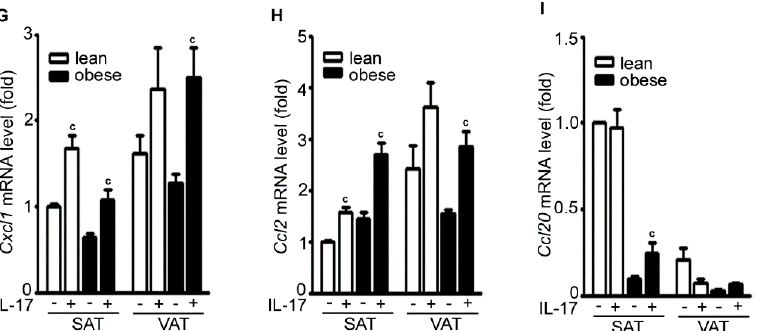
Figure 2. IL-17A differentially induces inflammatory gene expression in the adipose tissues of lean and obese mice. ( A – I ) Adipose tissues were cultured in serum-free Dulbecco’s Modified Eagle Medium (DMEM) and treated without ( − ) or with (+) 20 ng/mL IL-17A for 2 h; mRNA expression of each gene was analyzed with qRT-PCR; SAT without IL-17A treatment served as the basal level for comparison; data represent mean ± SEM (error bars), n = 6 per group; a p < 0.05, compared to the untreated SAT group; b p < 0.05, compared to the lean mice; c p < 0.05, comparison between the untreated and IL-17A-treated groups.